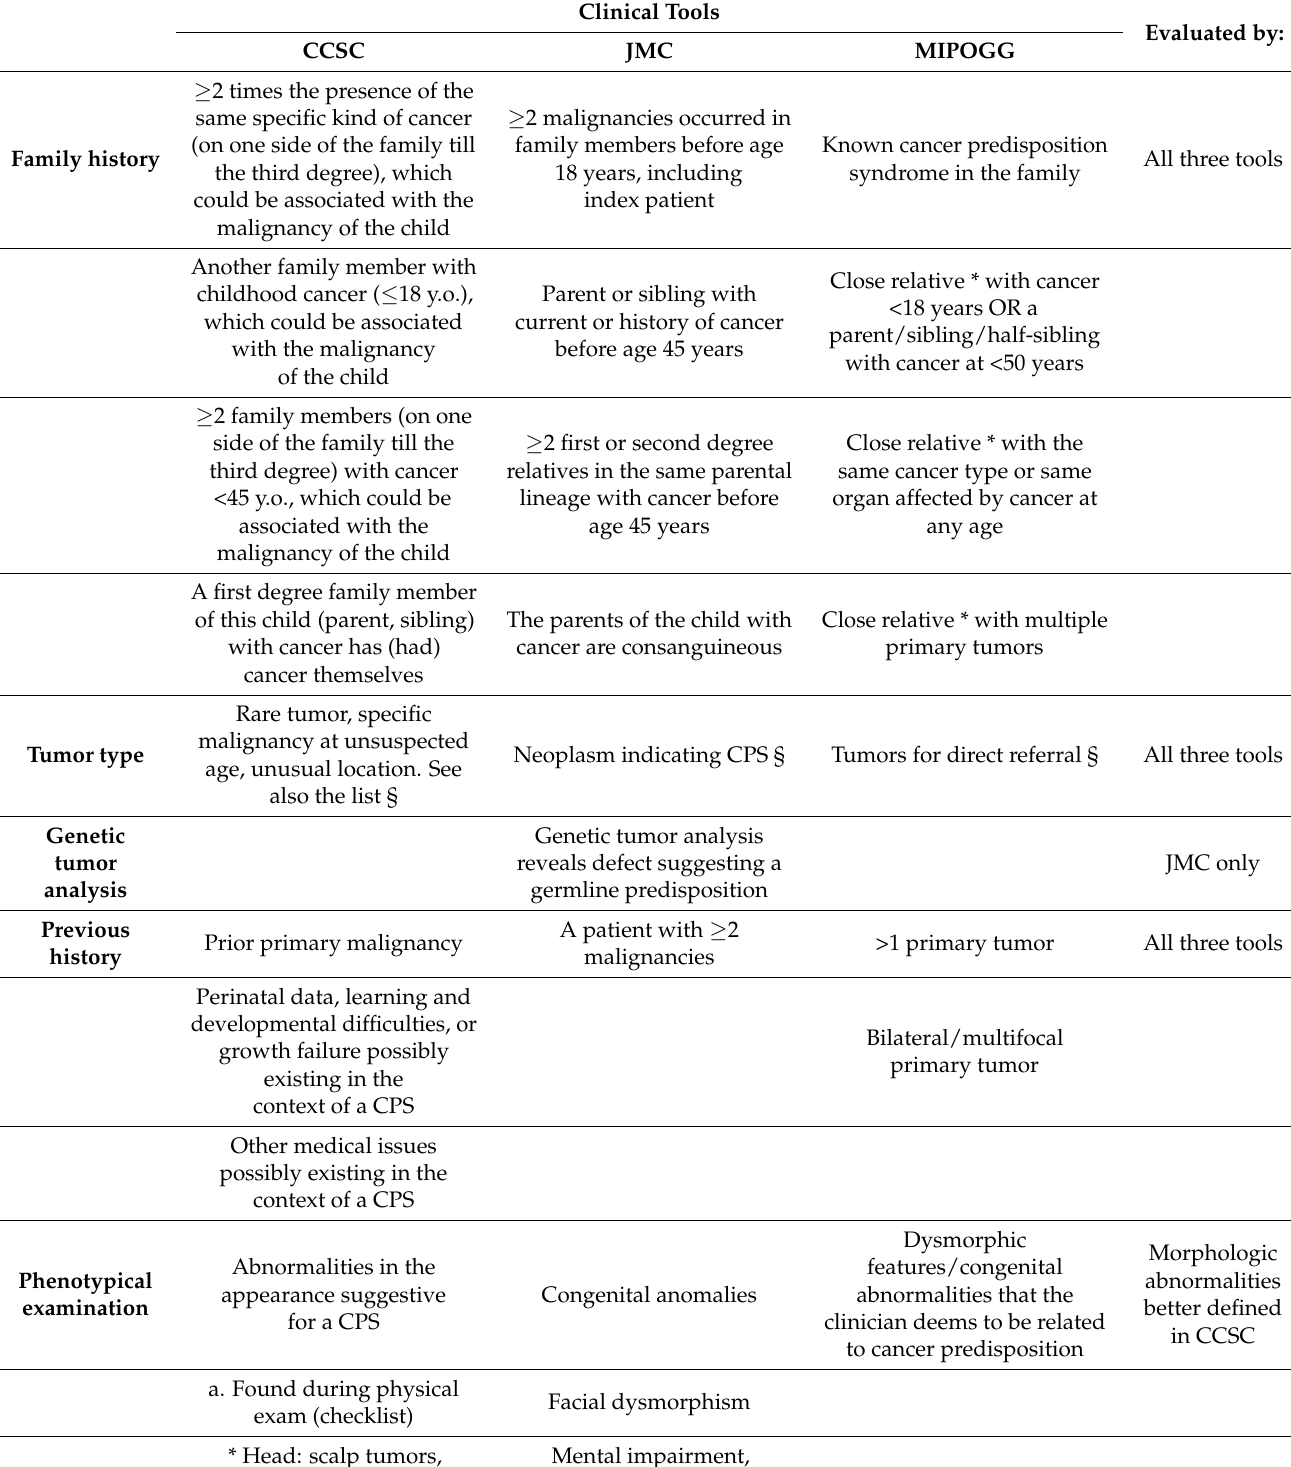
Table 2. Clinical screening